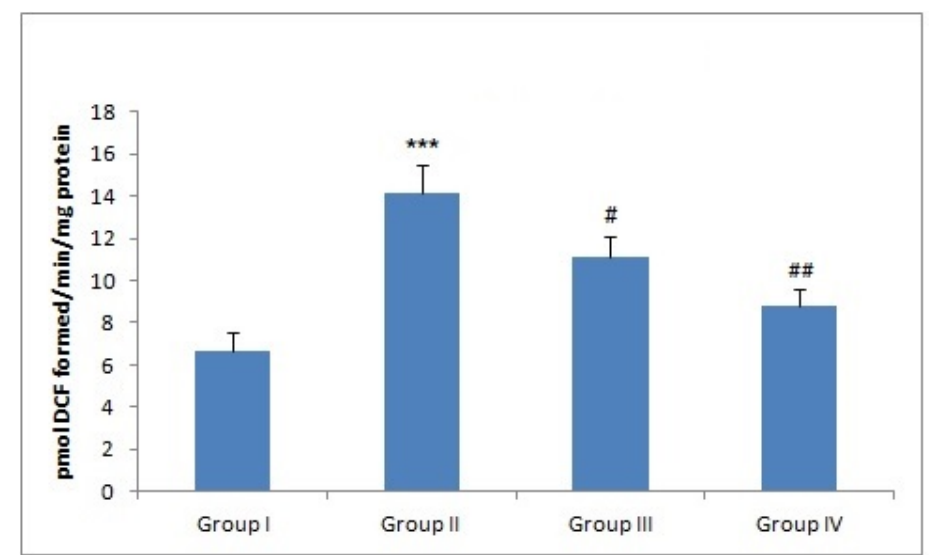
Figure 1. Effect of naringenin and doxorubicin treatment on ROS levels. In Dox-treated group-II, the reactive oxygen species (ROS) level was increased significantly (*** P < 0.001) as compared to the control group -I. Treatment with naringenin (50 and 100 mg / kg b. wt.) significantly attenuated ROS levels in group III ( # P < 0.05) and group IV ( ### P < 0.01) as compared to group II.